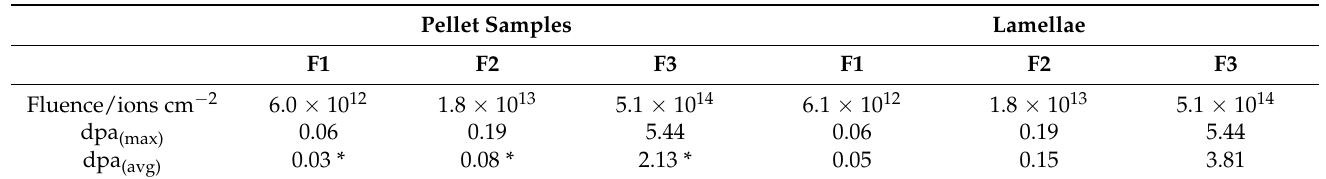
Table 4. Results of SRIM/TRIM simulation of external Au ion irradiation of monazite-structured SmPO 4 pellets and lamellae.